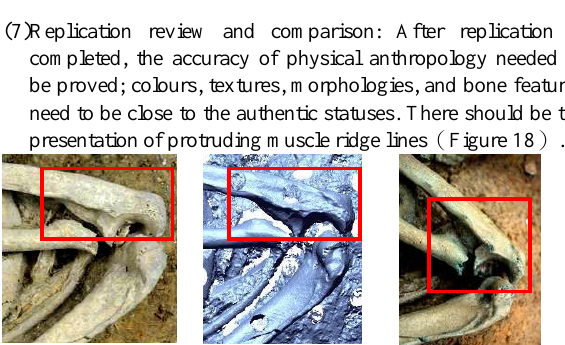
Figure 18. Unearthed human remains (left); digital module (middle); and human remains replication